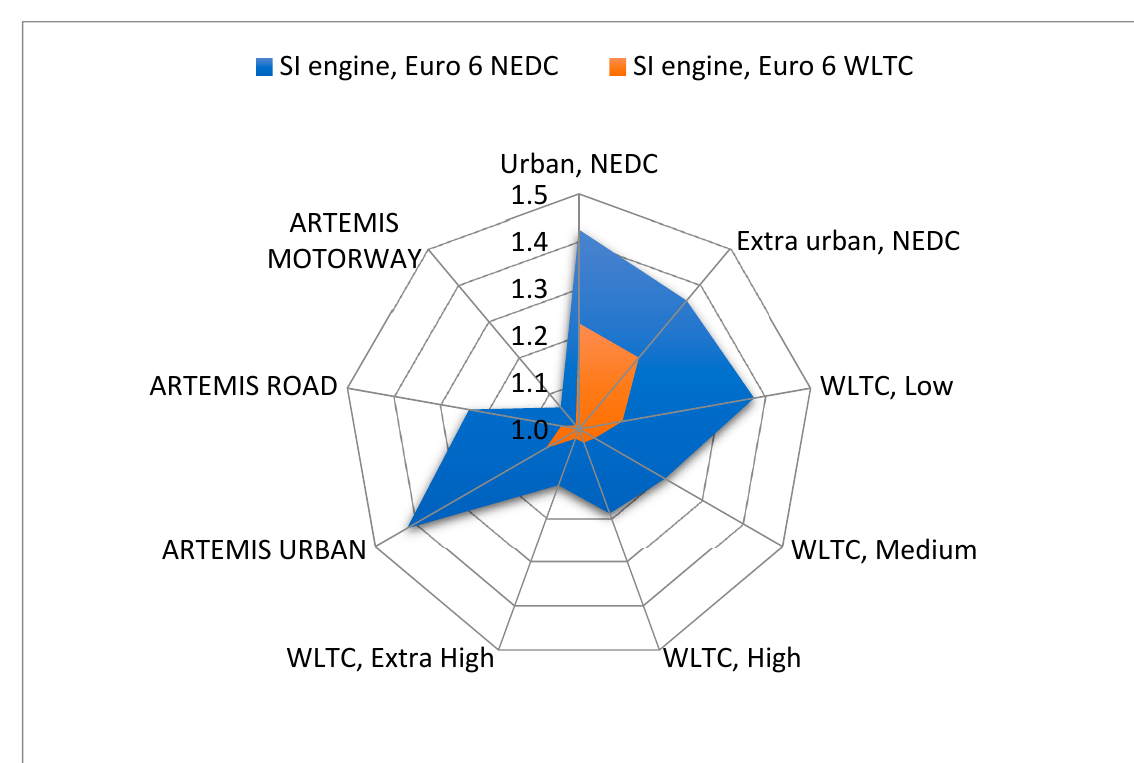
Figure 9. The median of the λ in driving cycles for a vehicle equipped with spark ignition engine, Euro 6 WLTP.